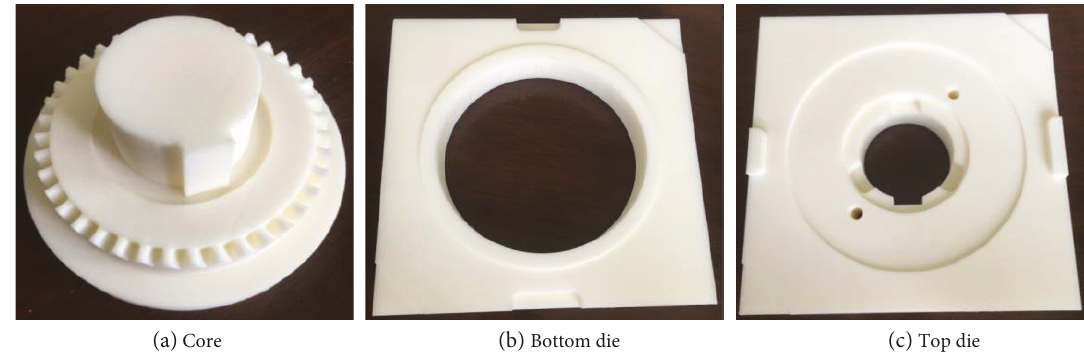
Figure 14: The parts forming the spur face gear master